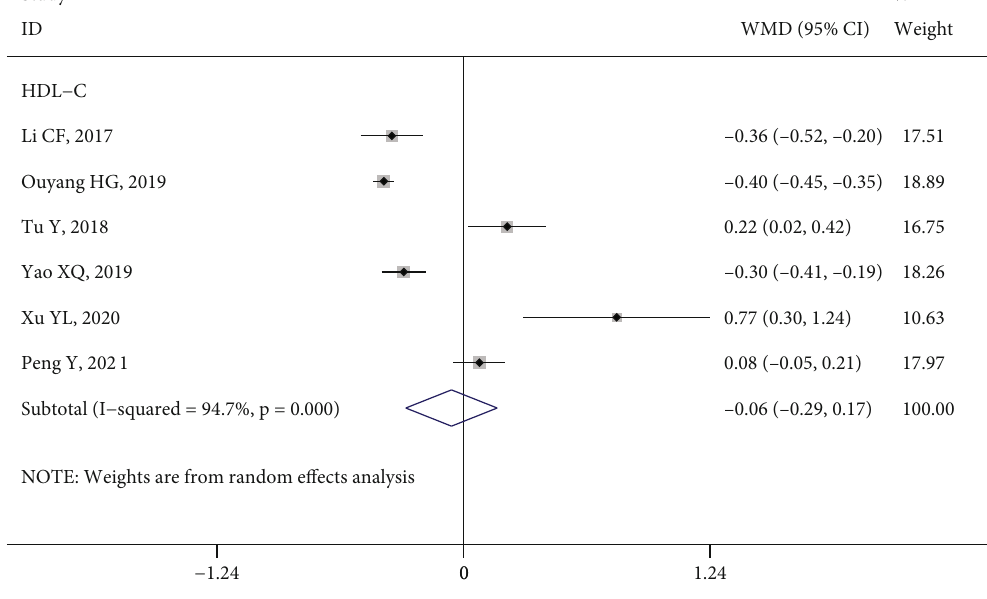
Figure 8: Forest plot of the e ff ect of health literacy intervention on